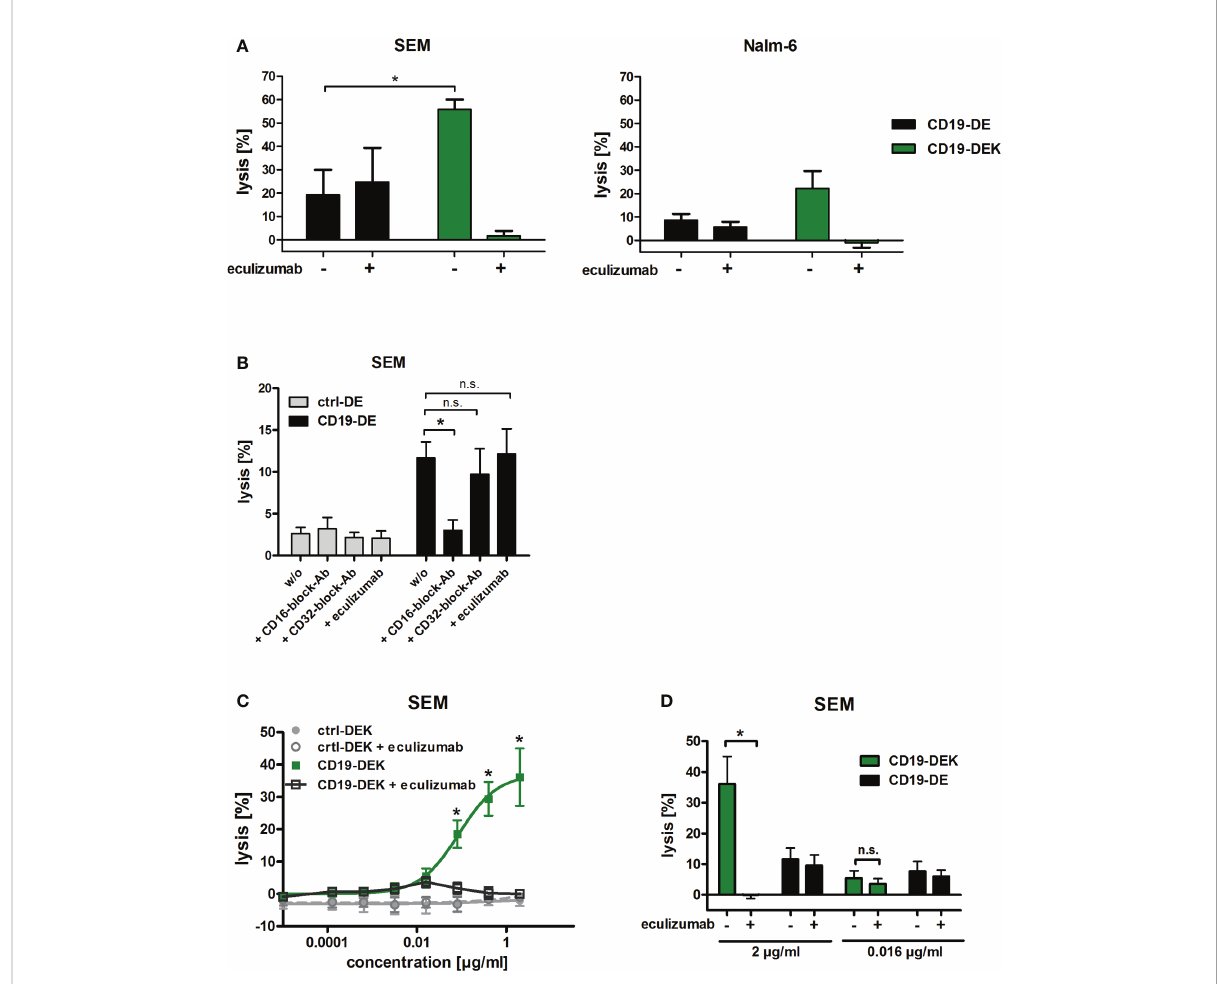
FIGURE 4 The dual-engineered antibody CD19-DEK showed improved cytotoxic activity compared to CD19-DE using whole blood as effector source. (A, B) Chromium release assays with a concentration of 2 µg/ml of the respective antibodies and 25% v/v whole blood of healthy donors was performed to analyze the combined anti-tumor effect of CD19-DEK via the complement system (CDC) and via recruitment of effector cells (ADCC). For inhibition of tumor cell lysis via the complement system the blood was supplemented with 50µg/ml eculizumab. Mean values ± SEM of three (SEM cells) or seven (Nalm-6 cells) independent experiments, * P <0.05% CD19-DEK vs. CD19-DE, One-way ANOVA with Bonferroni post-test. (B) For inhibition of tumor cell lysis via Fc g RIII (CD16) or Fc g RIIa (CD32a) expressing effector cells the blood was preincubated with 100µg/ml speci fi c blockade antibodies with an silenced Fc-part, lacking Fc g R binding. (C, D) Chromium release assays with the B-ALL cell line SEM and increasing concentrations of the respective antibodies and 25% v/v whole blood of healthy donors was performed. For inhibition of tumor cell lysis via the complement system the blood was supplemented with 50µg/ml eculizumab. Mean values ± SEM of three independent experiments, * P <0.05%, ns, not signi fi cant. One- or Two-way ANOVA with Bonferroni